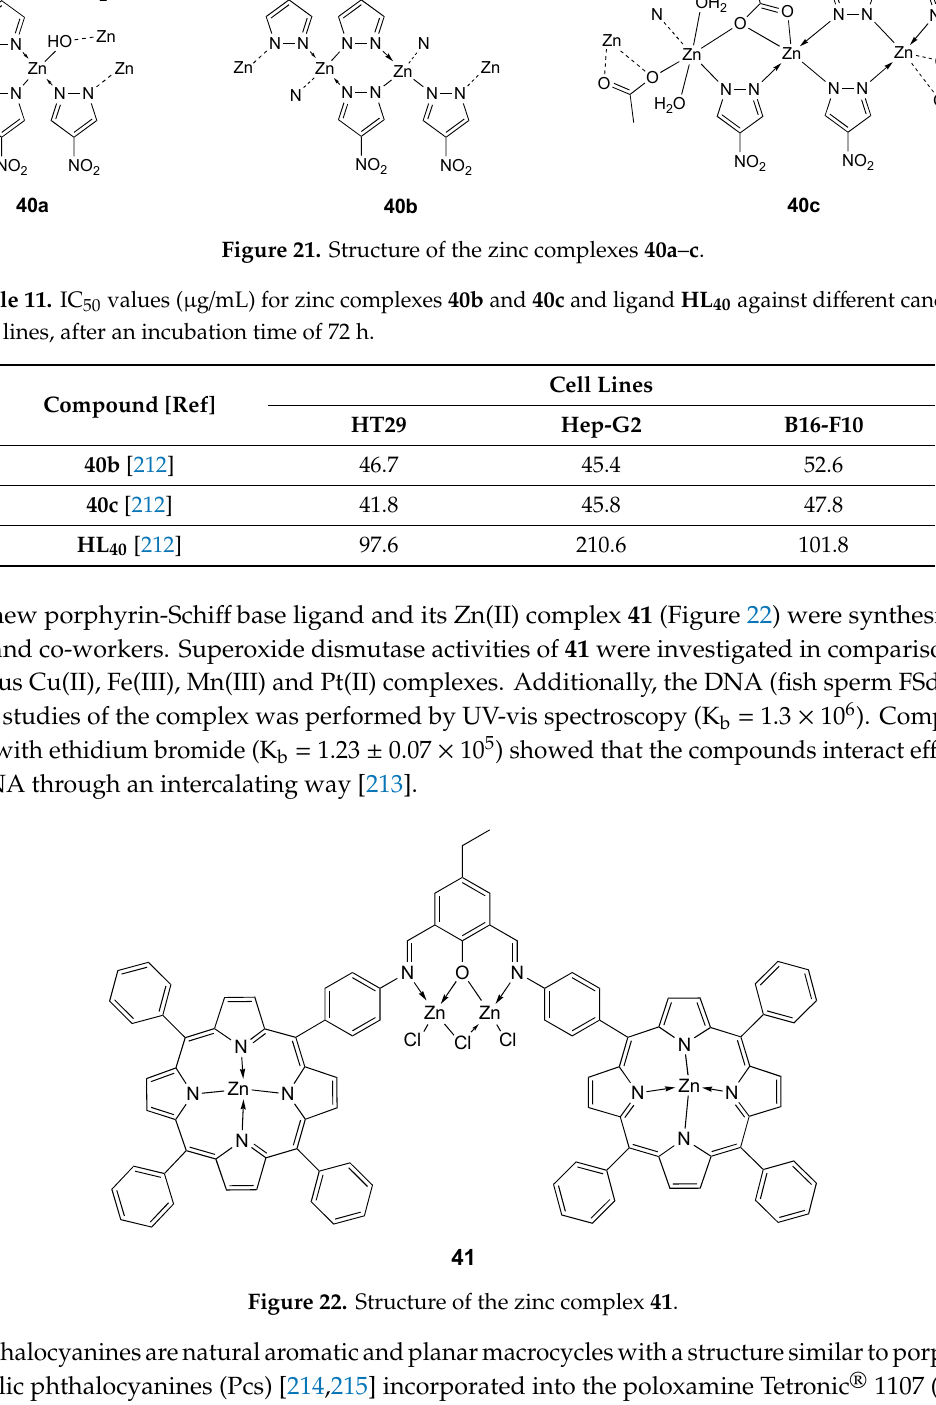
Figure 23. Structure of the zinc complexes 42 – 44 .